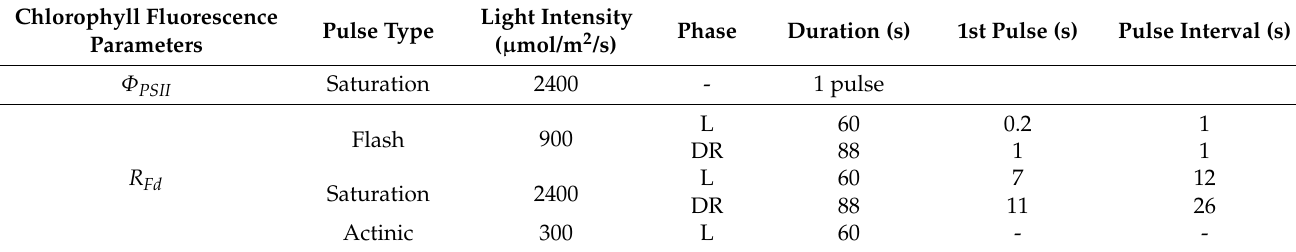
Table 6. Measurement protocol of the chlorophyll fluorescence.